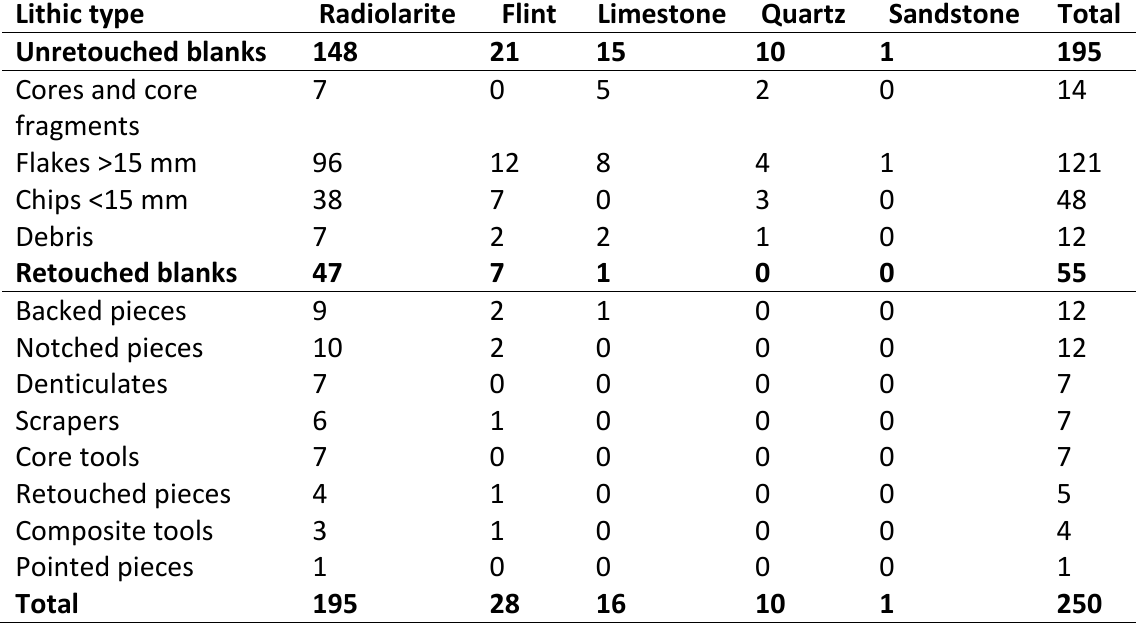
Table 3. Sample details by lithic and raw material